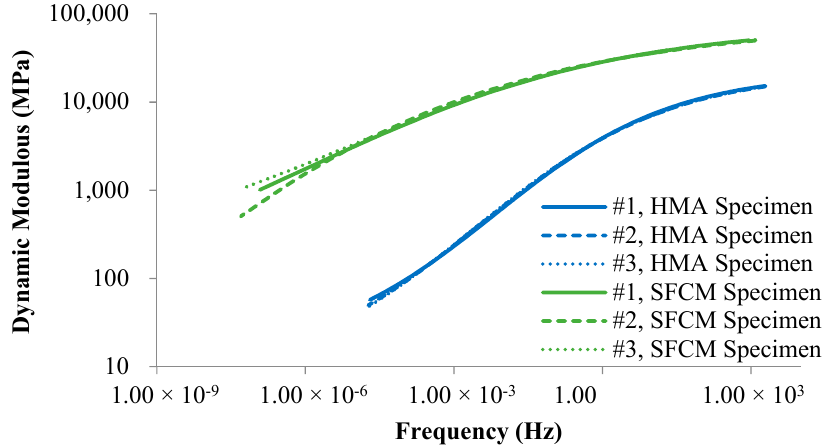
Figure 4. Comparison of dynamic modulus between semi-flexible composite mixture (SFCM) and hot mix asphalt (HMA) specimens.